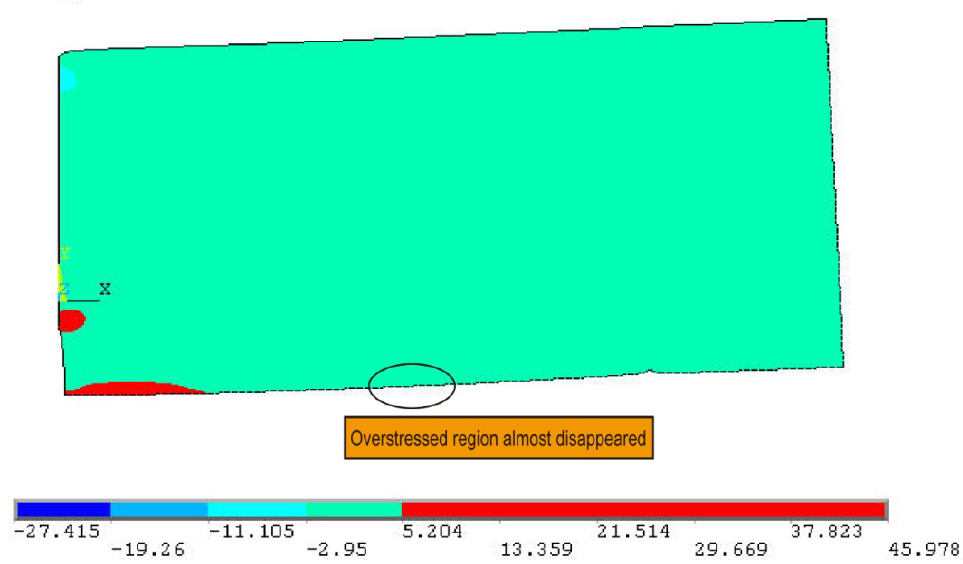
Figure 16. The distribution for the maximum principle stresses in concrete material at the end of the CFRP with a length of 0.30 m.